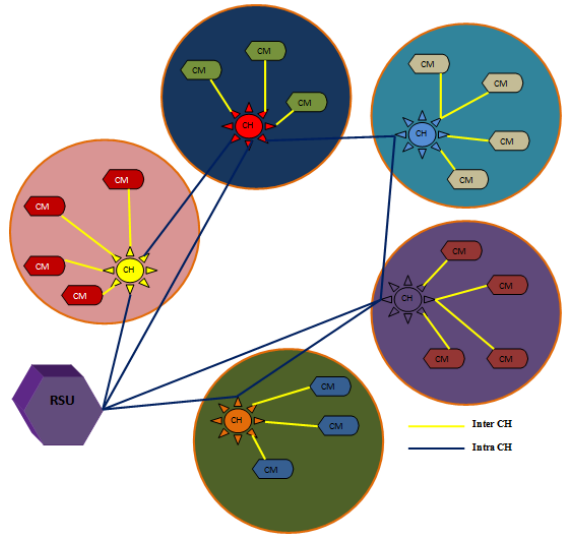
Figure 3. Inter CH Communication.